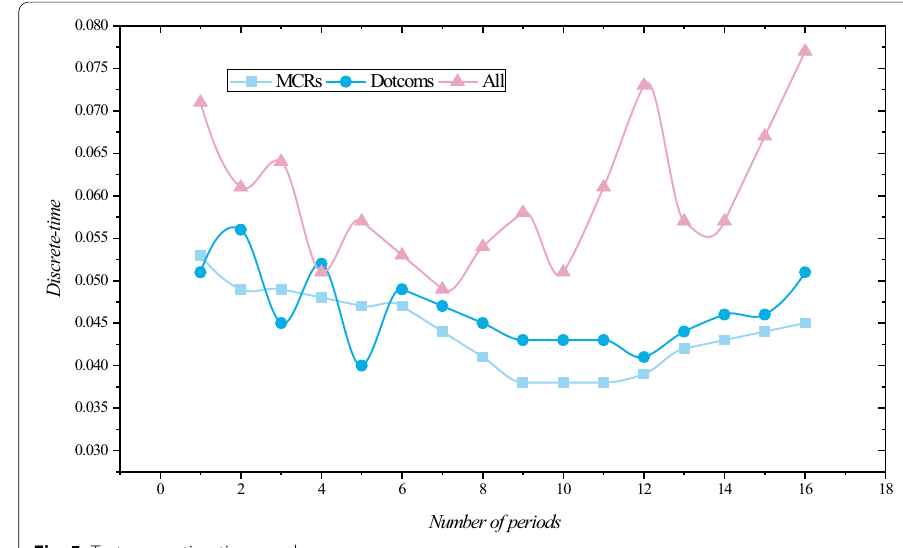
Fig. 5 Test generation times and convergence